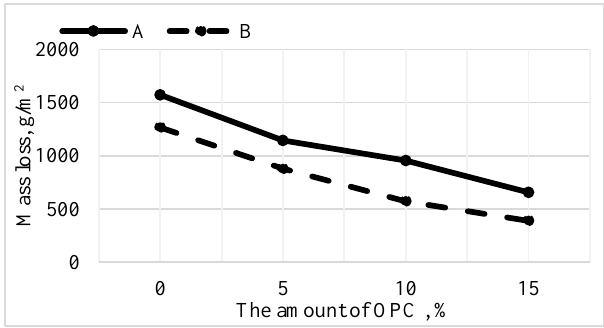
Figure 6. Additional OPC influence on alkali-activated concrete resistance to repetitive freeze/thaw.